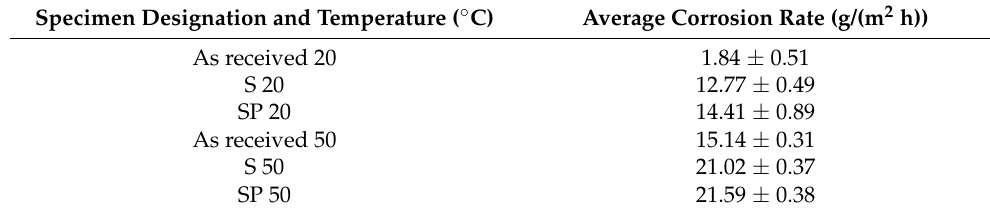
Table 6. Average corrosion rates calculated from mass losses during the exposure test. Specimen Designation and Temperature (°C)